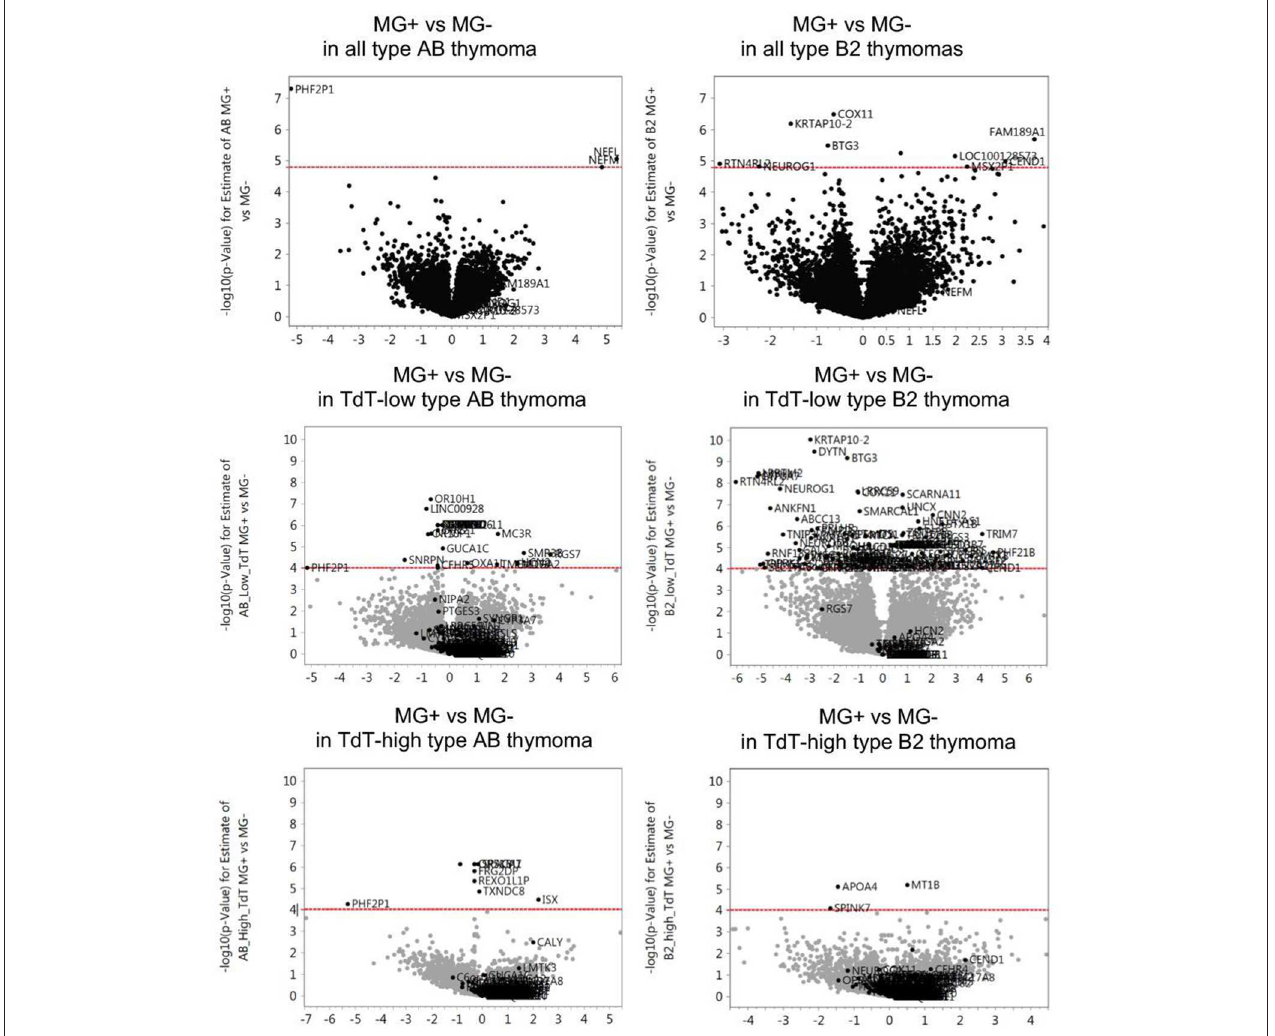
FIGURE 1 | Differentially expressed genes between MG + and MG- thymomas in type AB and B2 thymomas. For each gene the -log10 ( p -value) for the difference of gene expression levels between MG + and MG- groups (vertical axis) is plotted against its log2(fold change) relative expression level of the MG + group compared to the MG- group (horizontal axis). The dashed red line represents the statistical significance threshold ( P ≤ 0.05 after adjustment with False Discovery Rate). In both type AB and B2 thymomas, the number of genes that were differentially expressed between MG + and MG- cases was higher in each of the TdT (terminal deoxynucleotidyl transferase, a bona fide marker gene of immature T lymphocytes)-low and TdT-high subgroups than in the non-stratified, i.e., total cohorts of AB and B2 thymomas. The differences between MG + and MG- cases were particularly obvious in both TdT-low